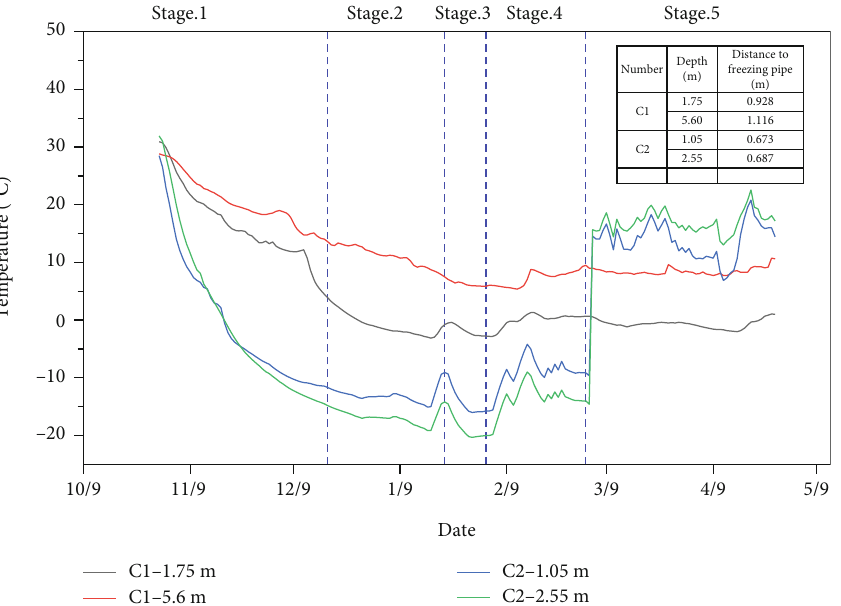
Figure 7: Temperature time history curve of C1 and C2.